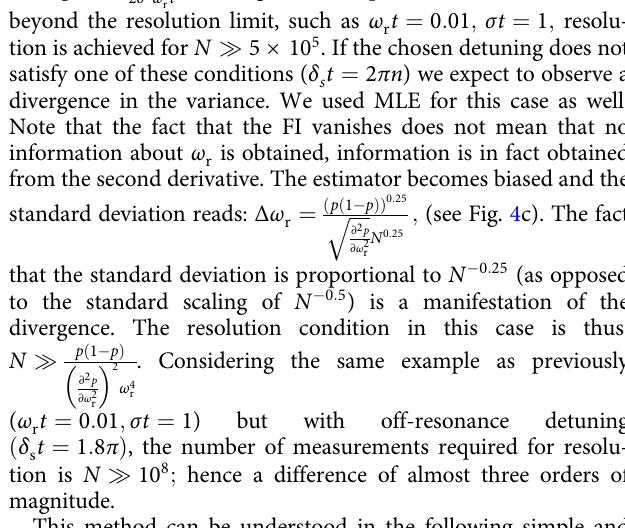
t for different values of δ t ¼ π (blue, solid line), : δ r s s t ¼ 2 π (dotted, yellow line). For every δ ; d p ¼ 0 for ω r ¼ 0. Hence a fi nite I r can be achieved only if p ¼ 0. This s s d ω r t ¼ 2 π n . b FI about ω t . Clear peaks can be observed whenever δ t ¼ 2 π n . The width of the peaks is ( I ) as a function of δ s r r s s t (cid:3) 1 this width goes as ω 0 ; the width vanishes; however fi nite ω leads to a fi nite width (given ω , see section “ Limitations r ¼ r r r t ¼ 0 : 001 (red, solid line), ω t ¼ 0 : 05 (black, dashed line), ω t ¼ 0 : 1 (blue, dotted r r r